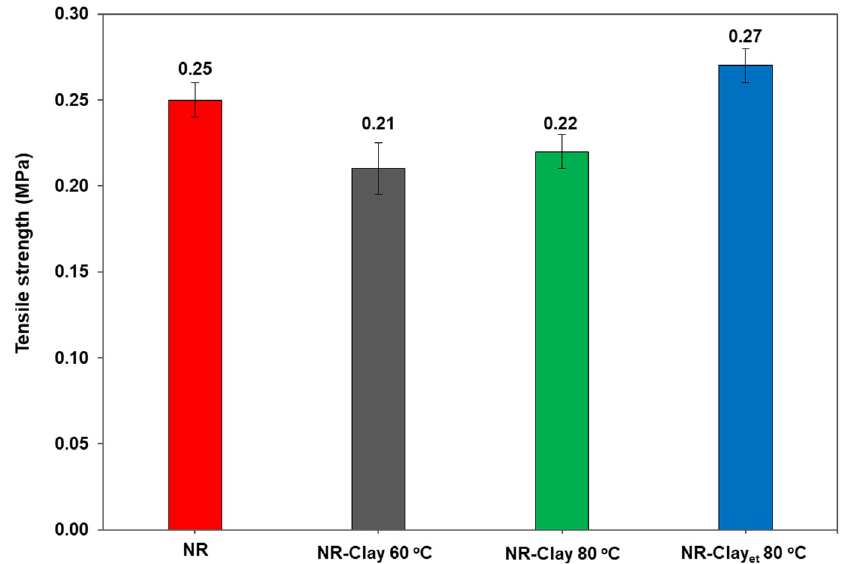
Figure 5. Tensile strength of NR, NR-Clay composites at various mixing temperatures (60 ° C, 80 ° C) and NR-Clay composites using Et-OH dispersed bentonite clay.